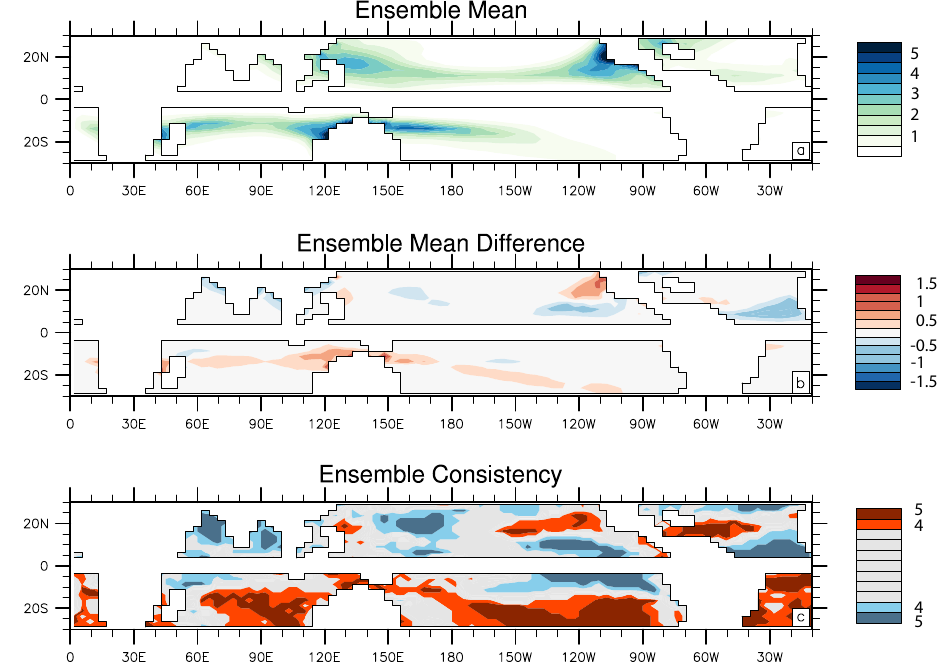
Figure 4. Panel (a) : mid-Holocene ensemble genesis potential index; panel (b) : mid-Holocene and preindustrial control ensemble GPI difference; and panel (c) : robustness of the palaeoclimate genesis potential signals, as indicated by the number of models agreeing with the direction of the change. Yellow and red denote areas for model agreement on positive sign change. Green and blue areas denote model agreement on negative sign change. Northern Hemisphere depicts JASO season, while Southern Hemisphere depicts JFMA season. Units in (a) and (b) are 10 − 13 normalised occurrences m − 2 month − 1